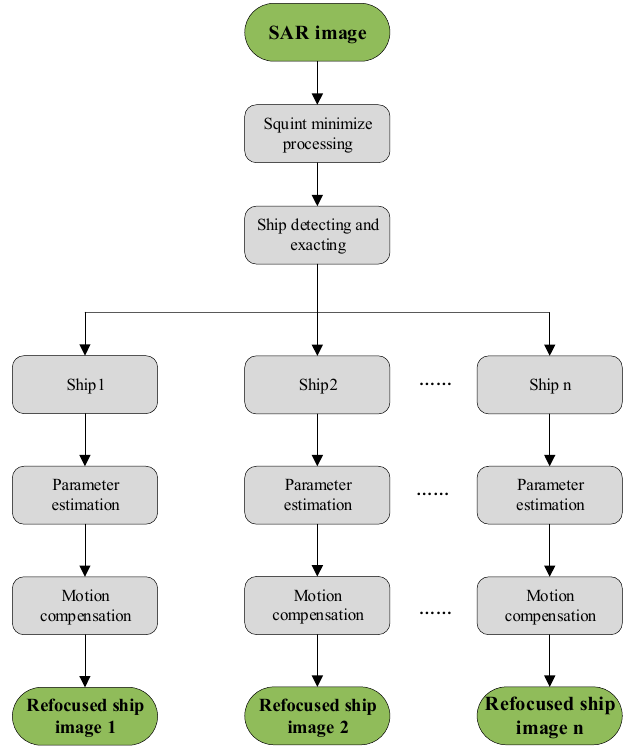
Figure 15. Flowchart of the squint-minimized-based refocusing algorithm for multiple moving targets in a large scene.